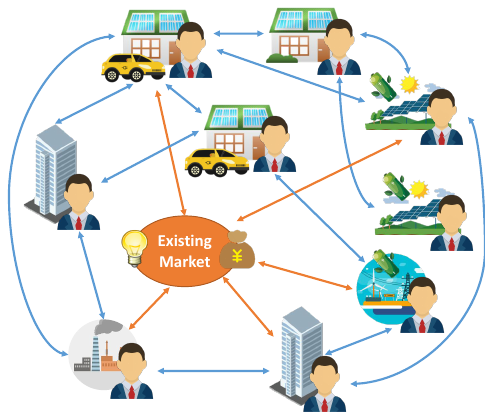
Figure 1. P2P energy-trading market